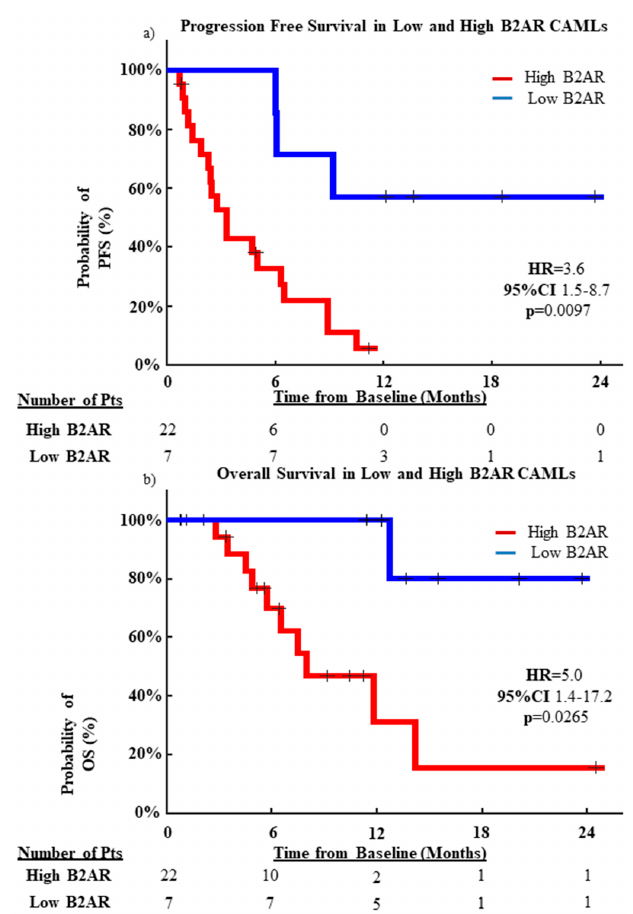
Figure 4. Kaplan – Meier graphs of PFS and OS for B2AR expression between high- and low-B2AR-expressing patients for total patient population. ( a ) PFS of patients with high-B2AR CAMLs (mPFS = 3.0 months) vs. low-B2AR CAMLs (mPFS = 10.9 months). ( b ) OS of patients with high-B2AR CAMLs (mOS = 5.5 months) vs. low-B2AR CAMLs (mOS = 13.4 months).